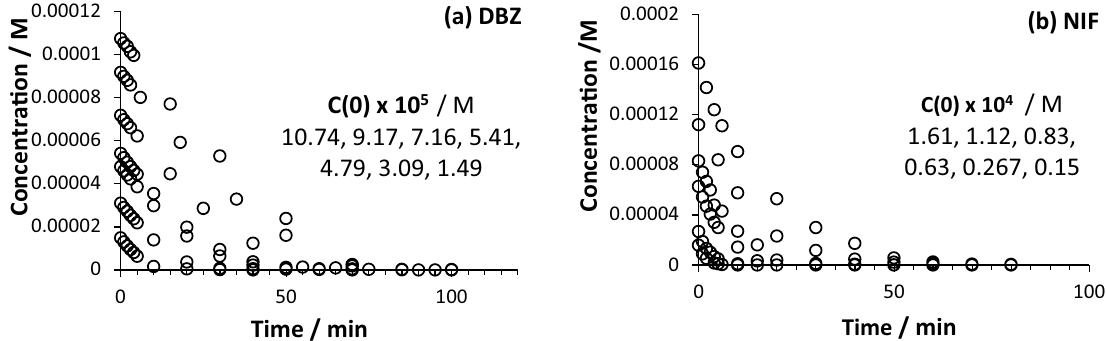
Figure 6. Photokinetic traces of ( a ) DBZ and ( b ) NIF under polychromatic light using the mixed-wavelength lamp #4 (254/365 nm). The experimental data (circle) were determined by HPLC.